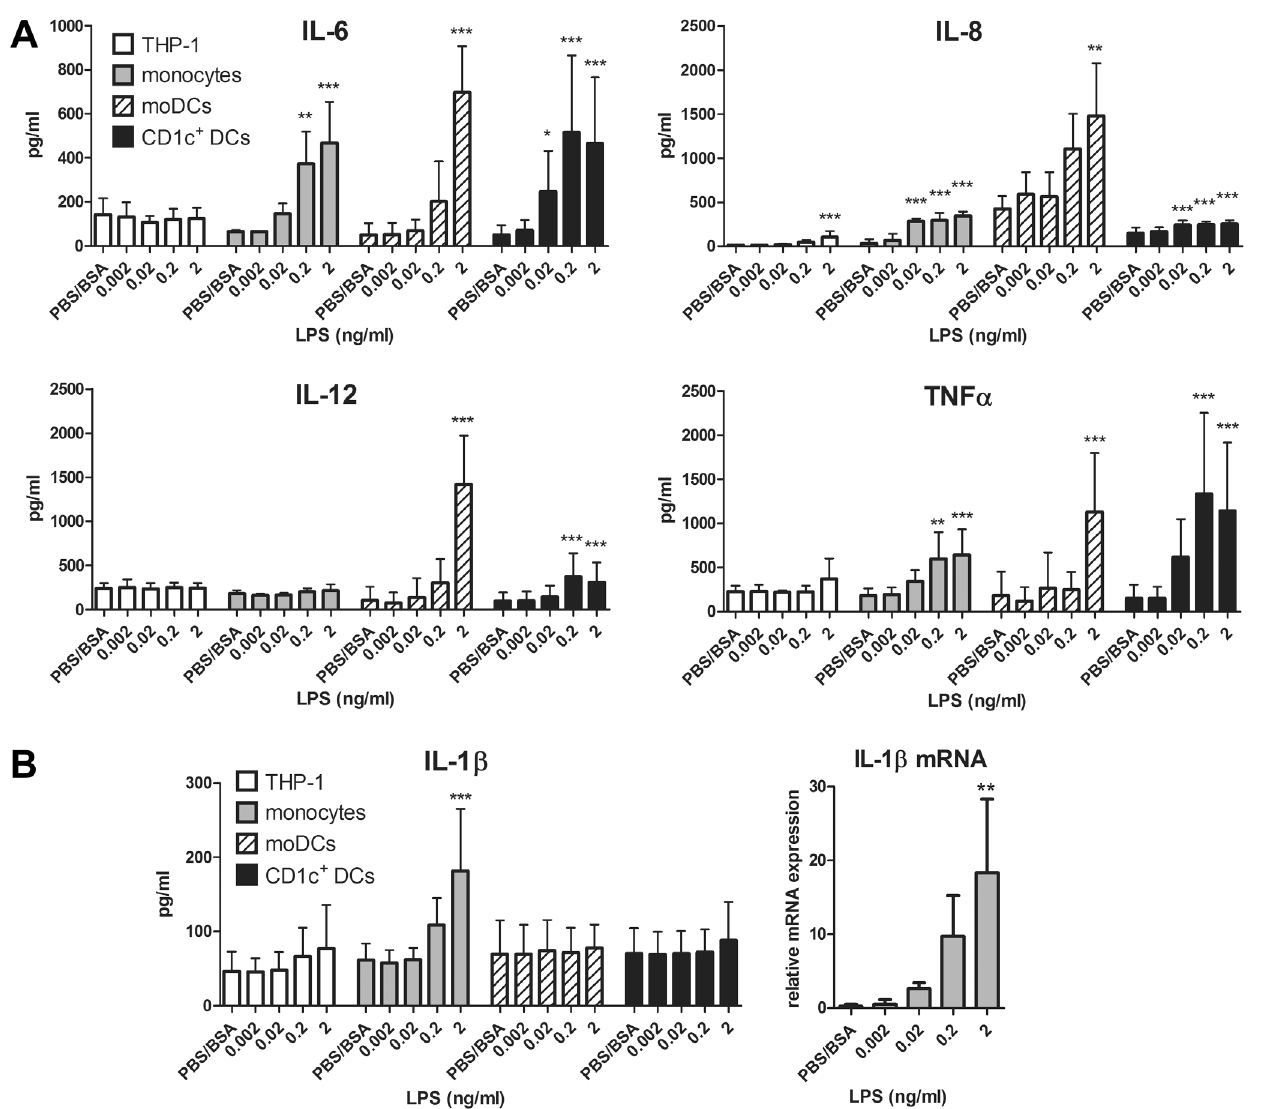
Figure 3. Effects of low LPS concentrations on cytokine production in different human immune cells. A 1 6 10 5 THP-1 cells, primary human monocytes, monocyte-derived DCs (moDCs), or CD1c + DCs were either stimulated with different concentrations of LPS or solvent (PBS/BSA) as a control. After 16 h, supernatants were harvested and analysed by ELISA. Results show means and SD of at least four independent experiments per cell type. B Left panel: Cells were plated and stimulated as described above. After 24 h, supernatants were harvested and analysed for IL-1 b expression by ELISA. Results show means and SD of at least five independent experiments per cell type. Right panel: 1 6 10 5 monocytes were stimulated as described above. After 6 h, cells were harvested and mRNA levels were measured by qRT-PCR. Results show means and SD of three independent experiments. One-way ANOVA with a Dunnett post-test was performed for each cell type individually. * p , 0.05, ** p , 0.01, *** p , 0.001 compared to the solvent control of the respective cell type.